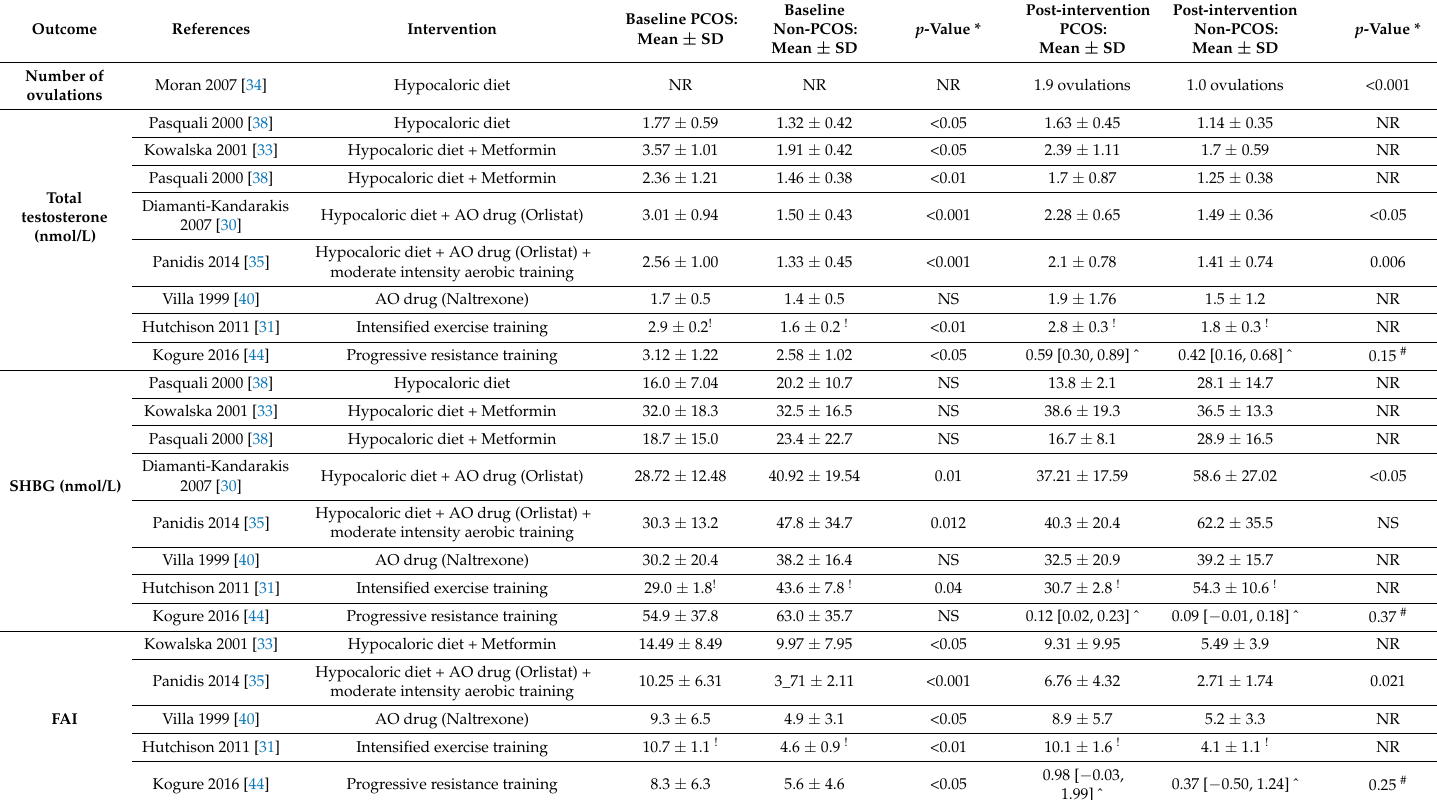
Table 3. Reproductive